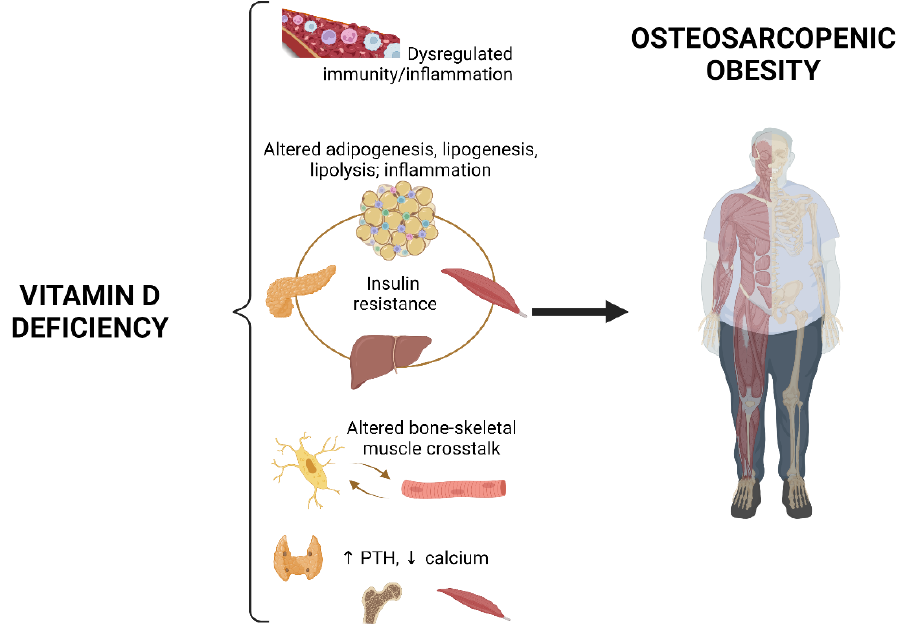
Figure 2. Potential role of vitamin D deficiency in the development of osteosarcopenic obesity. Vitamin D deficiency may reduce immune, antioxidant and anti-inflammatory capacity, is associated with multi-organ insulin resistance and altered adipogenesis, lipogenesis, lipolysis and inflammation in adipose tissue, might impair bone–skeletal muscle crosstalk and, by altering calcium–phosphorus metabolism, may impair muscle function and repair, chondrocyte maturation, bone mineralization and increase bone resorption. All these mechanisms could contribute (rightward arrow) to the development of osteosarcopenic obesity. PTH, parathyroid hormone. Upward arrow, increase; downward arrow, decrease. Created with BioRender.com, accessed on 31 March 2022.